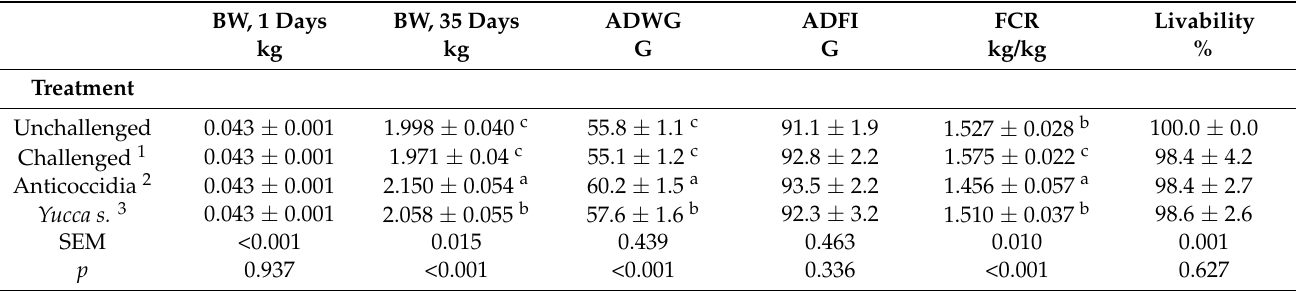
Table 3. Growth performance of unchallenged and challenged chickens for the period between 1 to 35 day of